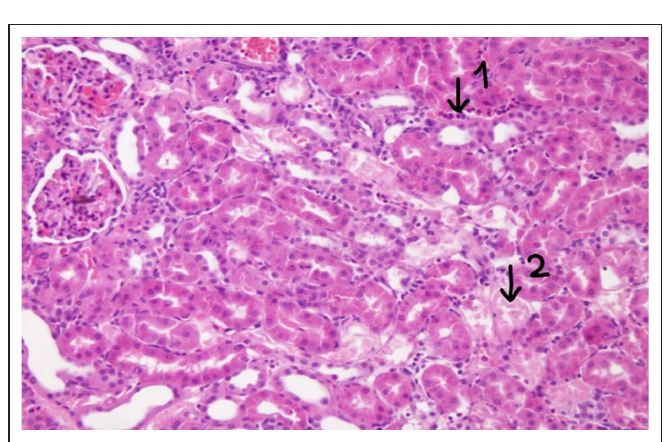
Figure 2. Light microscopic view of kidney of the GM group, mild tubulointerstitial inflammation (arrow 1) and tubular necrosis (arrow 2) are seen (H&E, × 200). H&E, hematoxylin and eosin; GM,